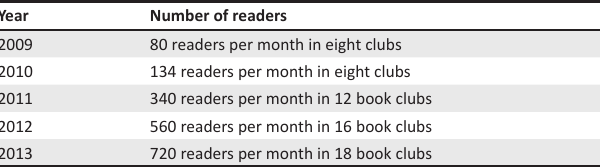
TABLE 1: Themes identified from monthly and yearly reports and field notes: Number of readers attending club meetings.